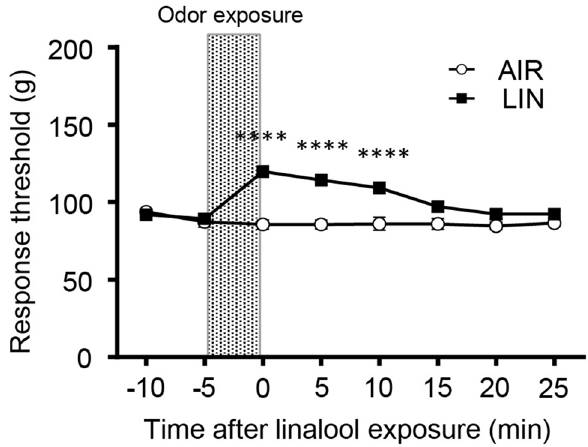
Figure 1. Five minutes of linalool odor exposure induced a sustained 10-min analgesic effect in the tail pincher test. The graph indicates alteration of the behavioral response threshold for mechanical nociceptive stimulation. The variation among animals was low enough that the error bars are hard to see in many time points. n = 10 for both odorless-air (AIR) exposed mice and linalool odor-exposed mice (LIN). The shaded area indicates odor